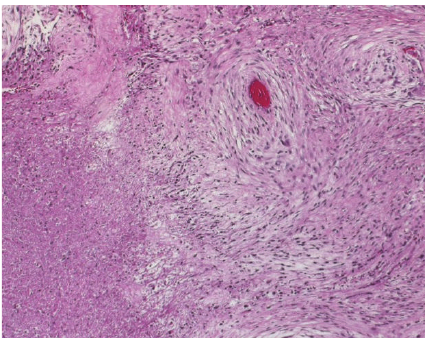
Figure 7: Microphotograph shows MTNST with extensive atypia, mitosis, and necrosis (Hematoxylin & Eosin, original magnification ×